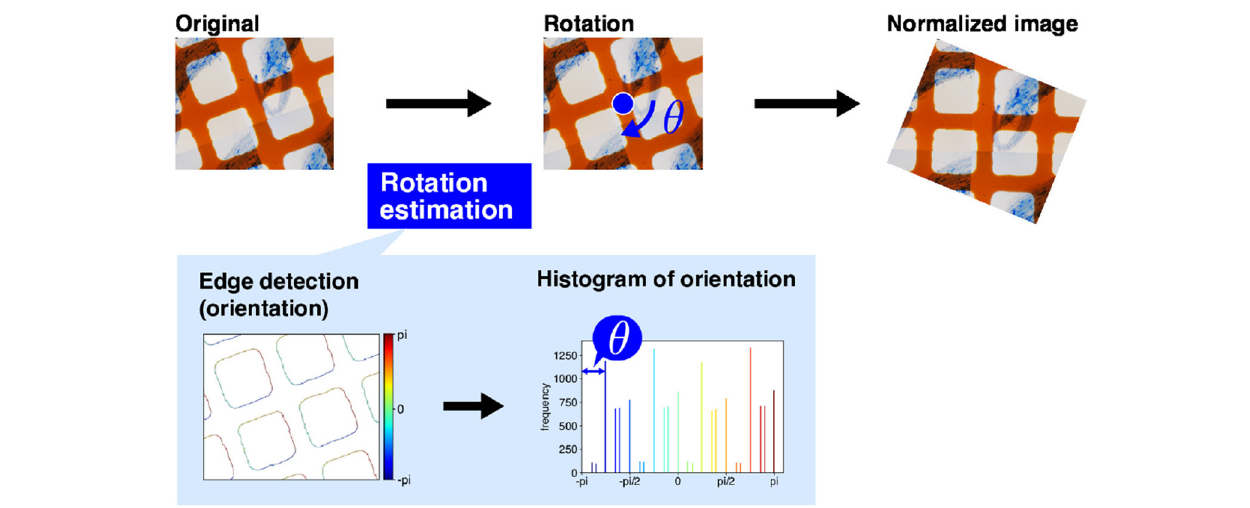
FIGURE 3 | Image rotation normalization. First, the dominant angles in the original image are calculated to estimate the directions of the grid lines. The input image is then rotated. The magnification of the slide images was 40x. The blue arrow mark and blue circle dot are rotation direction of image normalization and image center, respectively.